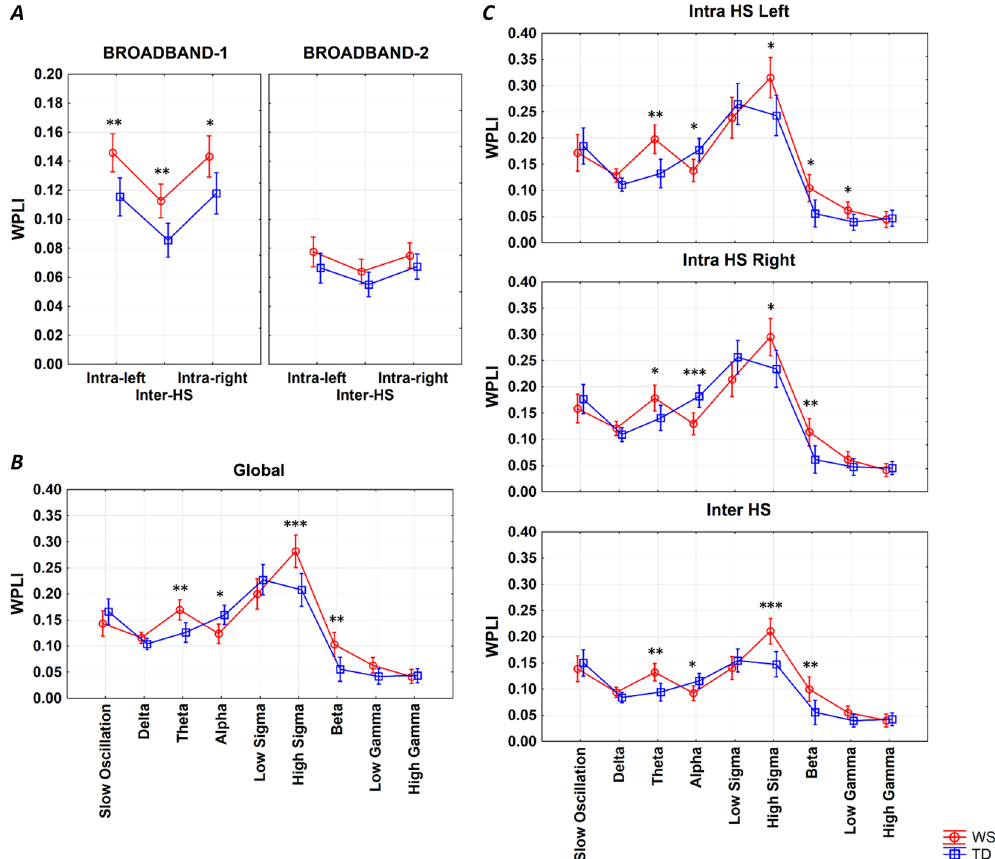
Figure 1. NREM sleep EEG WPLI means. ( A ) Intra- and interhemispheric NREM sleep EEG broadband-1 and broadband-2 WPLI means of Williams syndrome and typically developing subjects (means and 95% confidence intervals). Intra-left – left intrahemispheric, Inter-HS – interhemispheric, Intra-right – right intrahemispheric. * p < 0.05, ** p < 0.01, according to post-hoc Fisher LSD tests following a 3-way ANOVA with repeated measures (Group × Intrahemispheric/Interhemispheric × Band). ( B ) Band-limited global WPLI means of Williams syndrome and typically developing subjects’ NREM sleep EEG recordings (means and 95% confidence intervals). * p < 0.05, ** p < 0.01, *** p < 0.001, according to post-hoc Fisher LSD tests following a 2-way ANOVA with repeated measures (Group × Band). ( C ) Band-limited intra- and interhemispheric